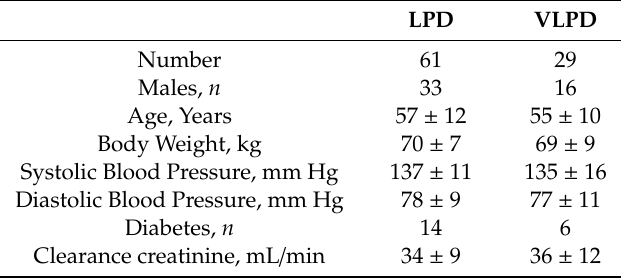
Figure 3. Death or dialysis in 61 patients treated with low-protein diet (0.6 g / kg / day) and 29 of them with Very Low Protein Diet (VLPD) (0.3 g / kg / day). Table 1. Baseline data.